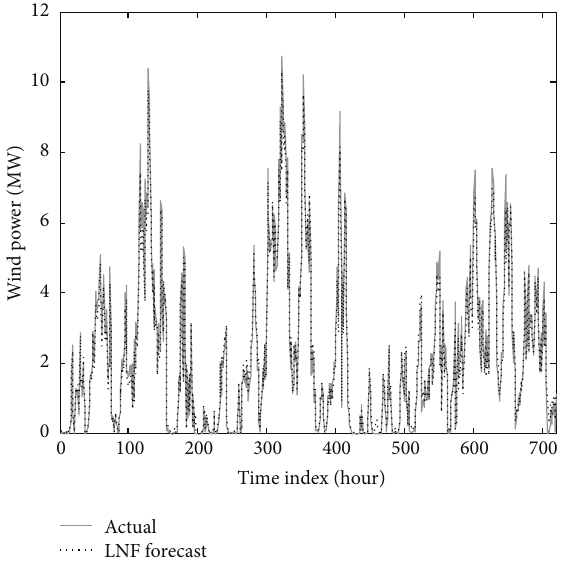
Figure 10: Actual and forecasted wind power for July 2010. approach proposed in [5] is a three-layer neural network model with fixed weighting parameters between the hidden layer and output node and ridgelets as activation